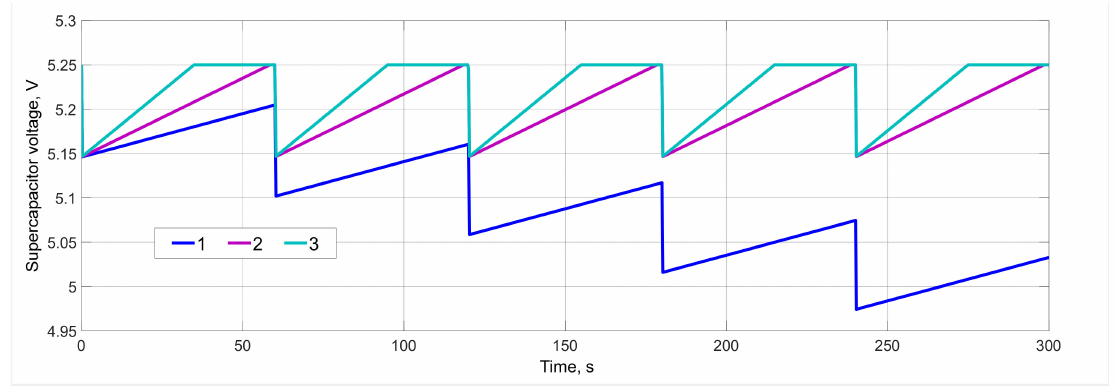
Figure 15. Virtual oscillograms of supercapacitor voltage. Inlet pressures of the vortex tube: 5 bar (1), 6 bar (2), and 7 bar